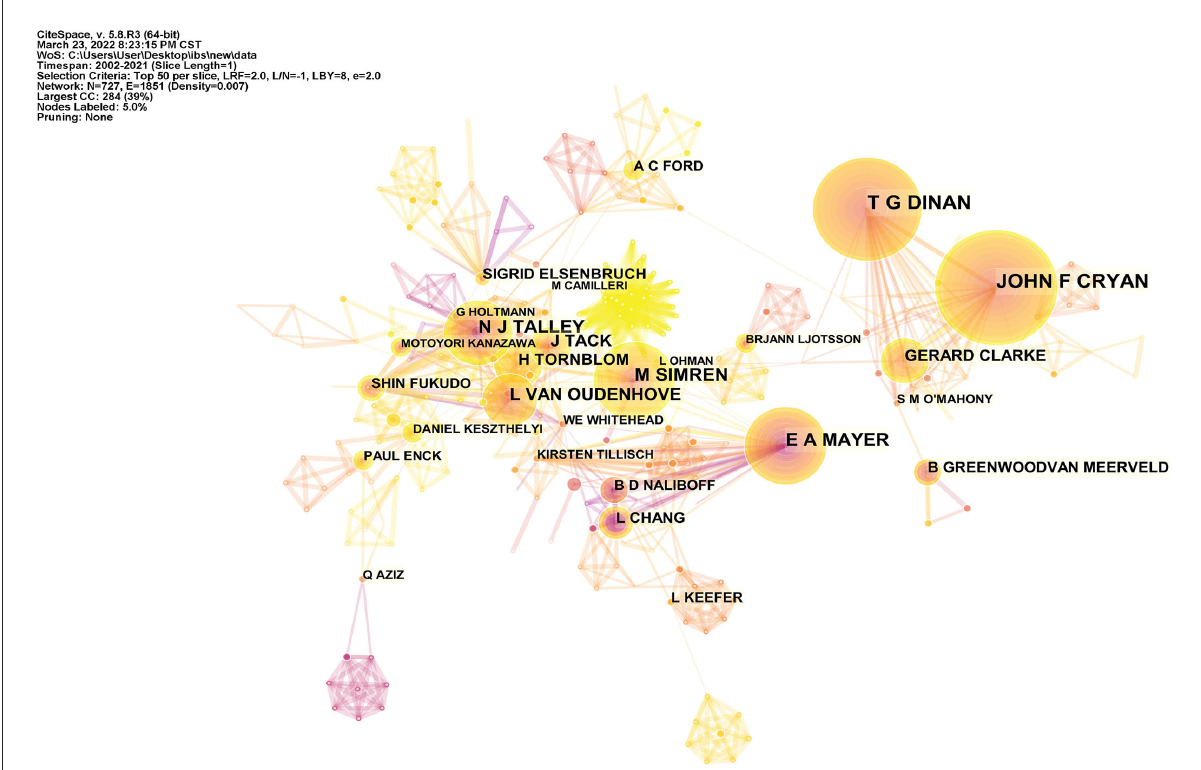
FIGURE5 Authors’ collaboration network of IBS research related to anxiety or